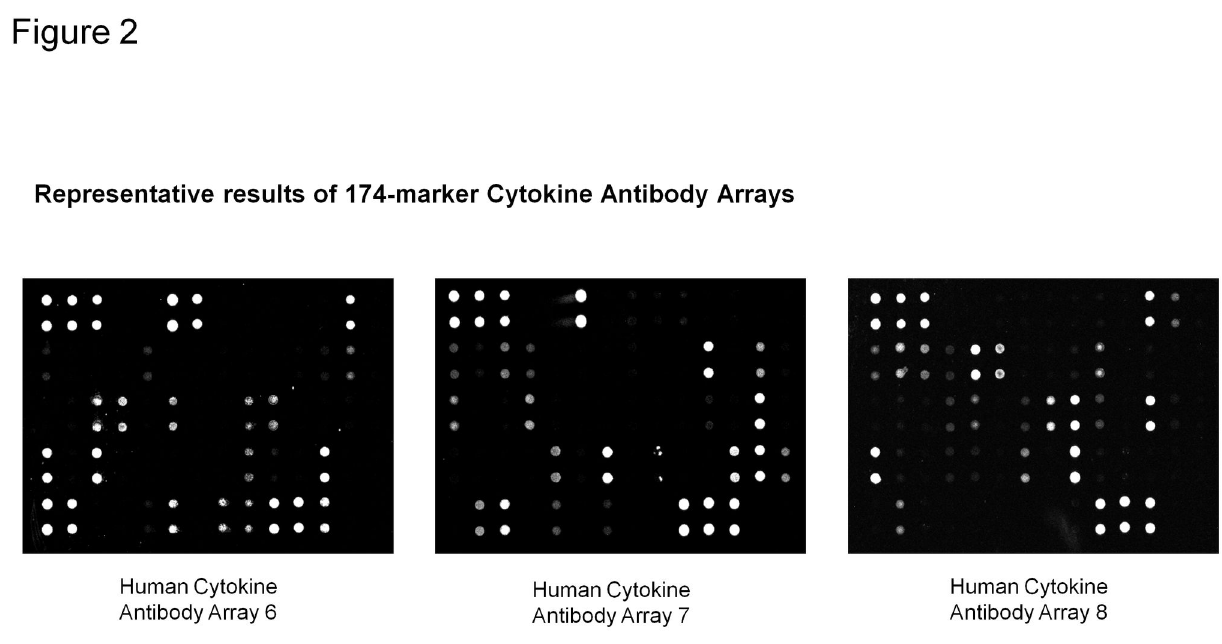
Figure 2. Representative results for 174-marker antibody arrays. Panel A (left) shows representative fluorescent signal images for array G6; Panel B (middle) shows representative fluorescent signal images for array G7; Panel C (right) shows representative fluorescent signal images for array